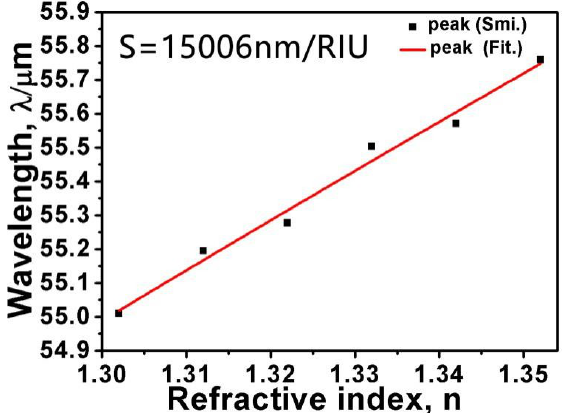
Figure 8. Simulated resonance wavelengths (black spots) and linear fit (red line) as a function of different values of surrounding refractive index n . Table 1. Sensitivity performance comparison between different absorber designs proposed in previous publications.